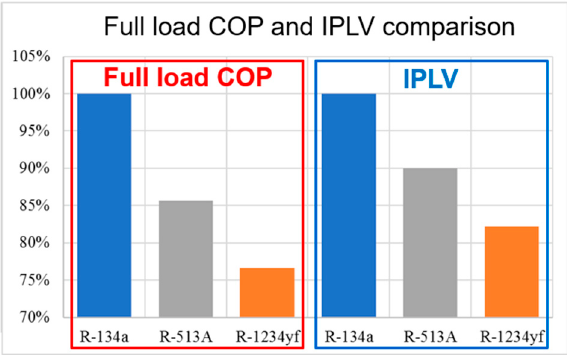
Figure 15. Comparison diagram of full load COP and IPLV of refrigerants.